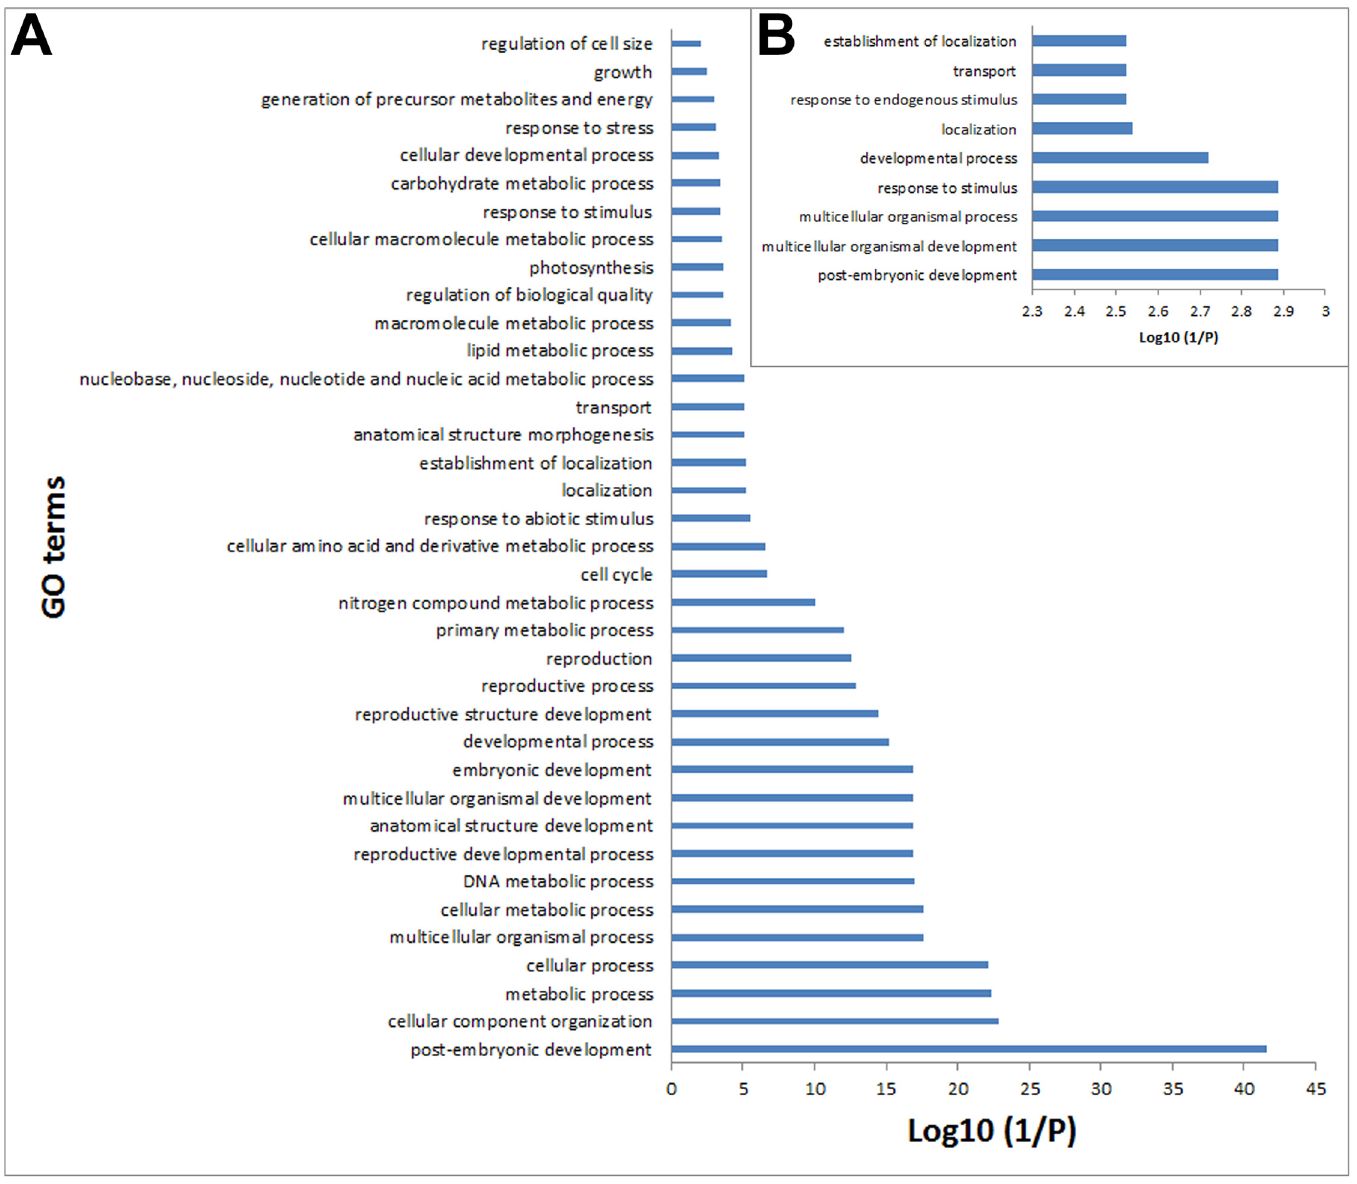
Fig 5. GO biological process term annotation of the conserved and lost genes common to both R . soongorica and sand rice. The (A) 5441 conserved and (B) 560 lost genes common to both